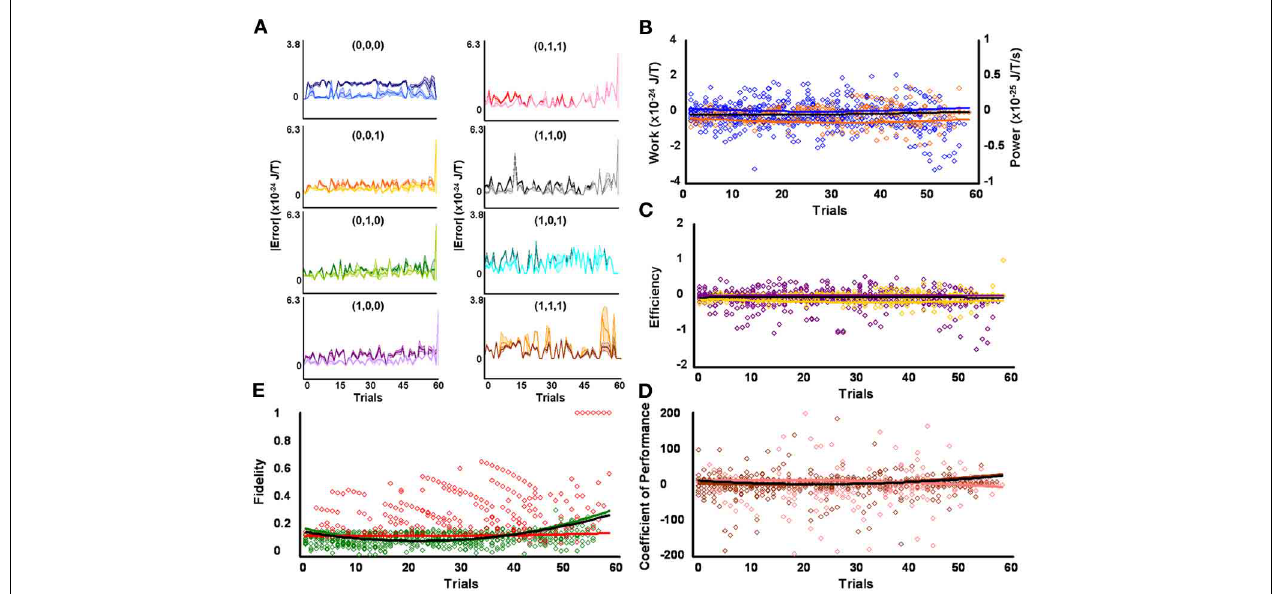
FIGURE 3 | Initial medium responders learn to diagnose and correct classical errors in executed contraction strategies signaling mating fitness. (A) Repetition coding prevented errors in executed serial contraction signals from exceeding estimated single bit-flip errors in absolute mean average Boltzmann entropy [executed (light blue) and bit-flipped (dark blue) strategy (0,0,0), executed (light orange) and bit-flipped (dark orange) strategy (0,0,1), executed (lime green) and bit-flipped (green) strategy (0,1,0), executed (lavender) and bit-flipped (purple) strategy (1,0,0), executed (pink) and bit-flipped (red) strategy (0,1,1), executed (gray) and bit-flipped (black) strategy (1,1,0), executed (turquoise) and bit-flipped (teal) strategy (1,0,1), executed (gold) and bit-flipped (brown) strategy (1,1,1)]. (B) Modest differences in mean average Boltzmann entropy between strategy planning and execution stages were expelled by ciliates when learning to detect and correct errors in modal (orange) and non-modal (blue) serial contraction signals.